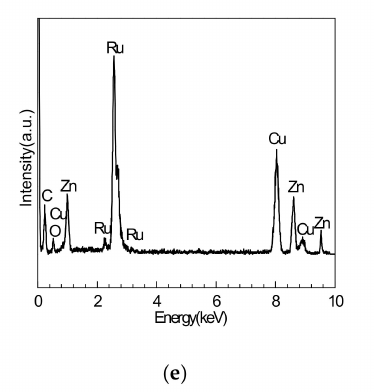
Figure 2. HRTEM ( a ), particle size distribution (insert image) and EDS ( b ) of fresh Ru@Mn 3 O 4 (0.46) as well as TEM ( c ), HRTEM ( d ), particle size distribution (insert image) and EDS ( e ) of spent Ru@Mn 3 O 4 (0.46).